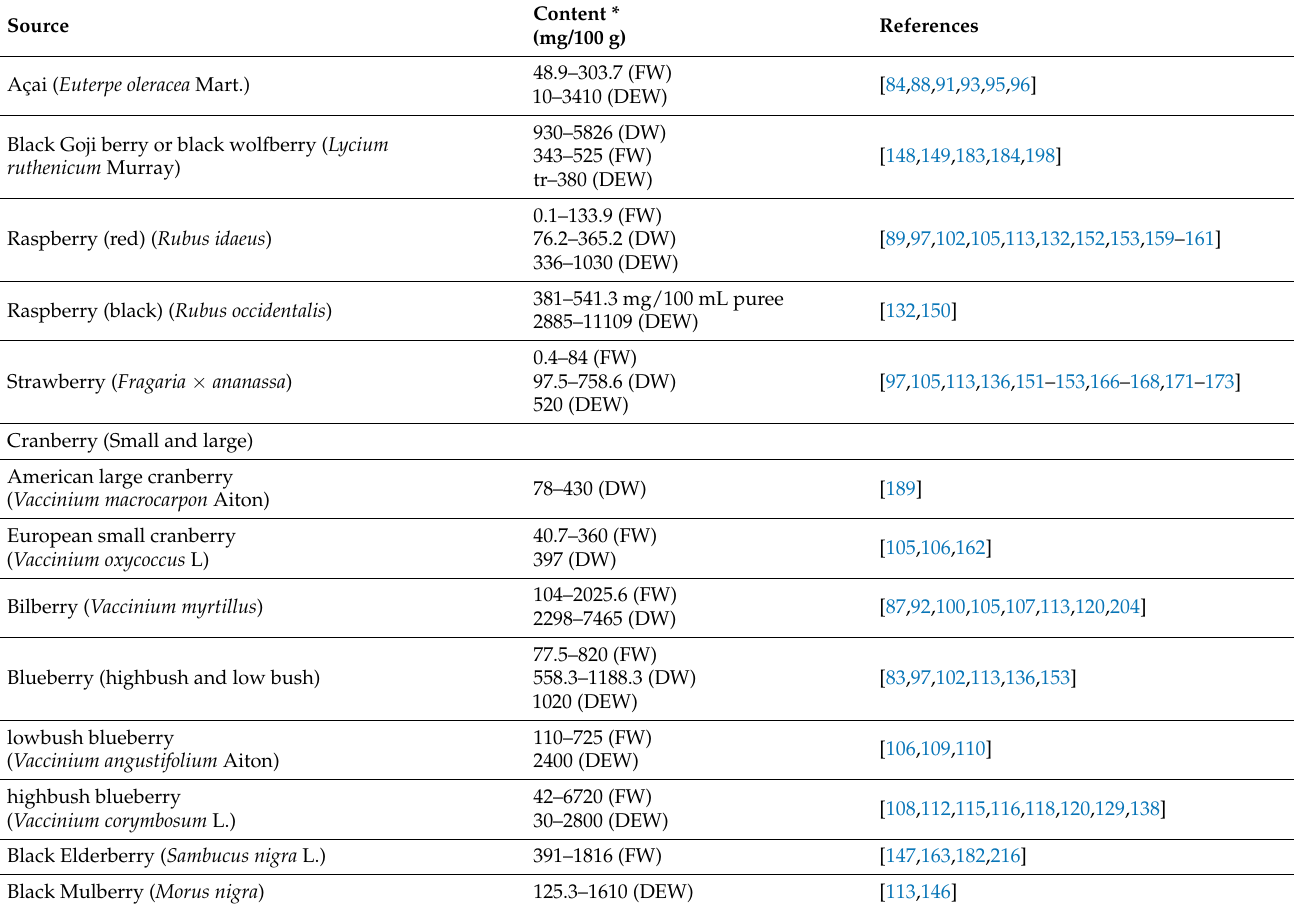
Table 5. Total anthocyanin content of commonly consumed berries and fruits using analytical